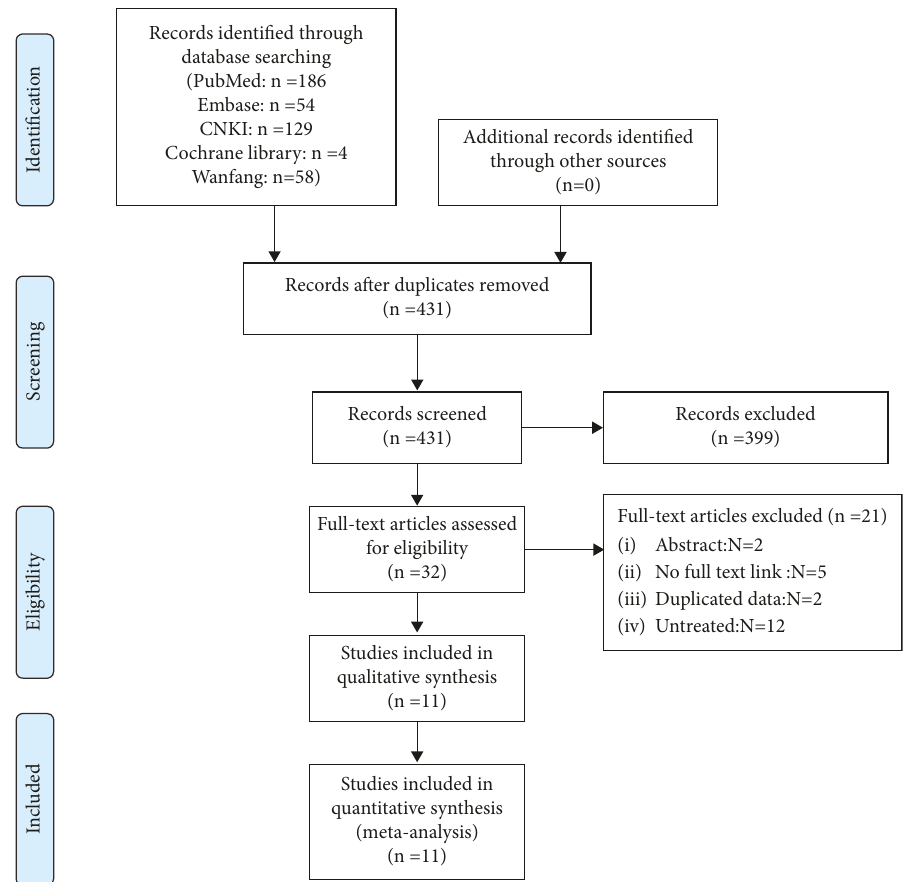
Figure 1: Flowchart of literature